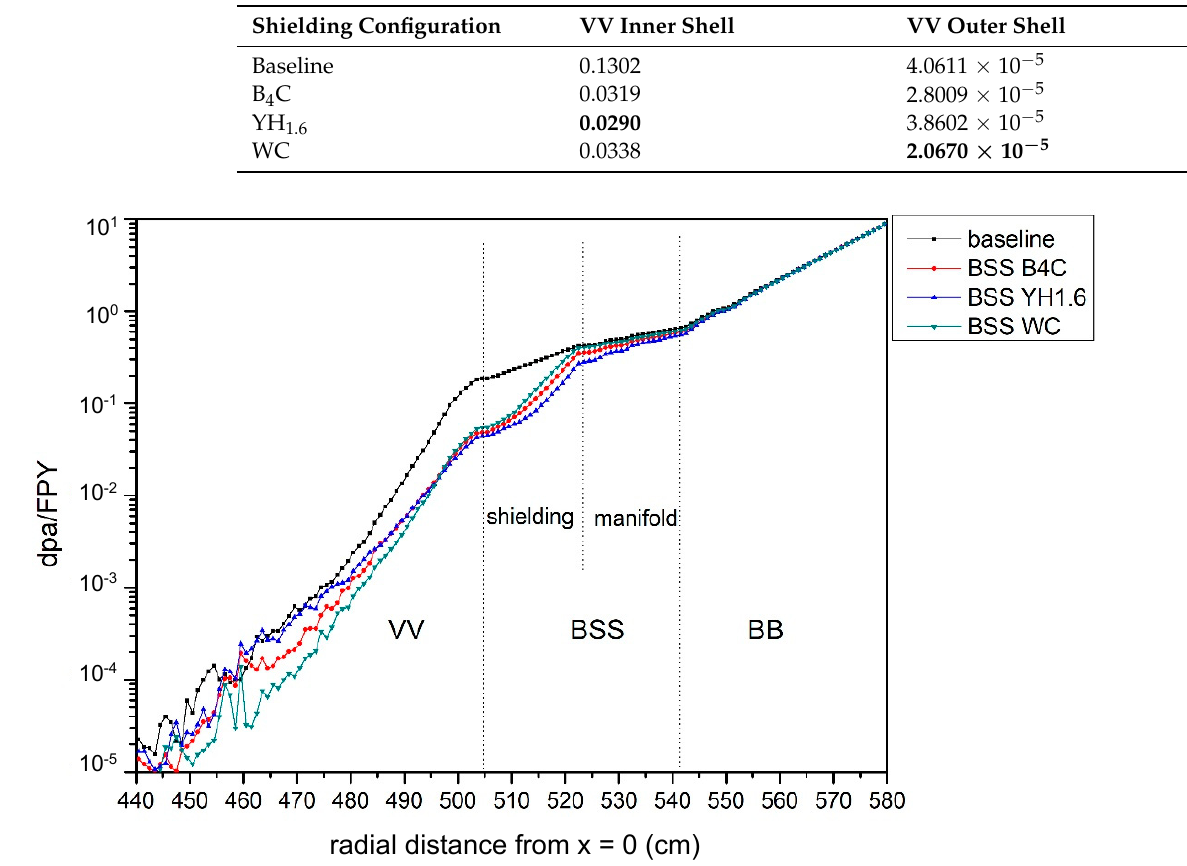
Table 1. Damage function (dpa/FPY) in different cells of the inner and outer VV shell at the equatorial IB level for the baseline model and 3 configurations of the BSS shielding materials.